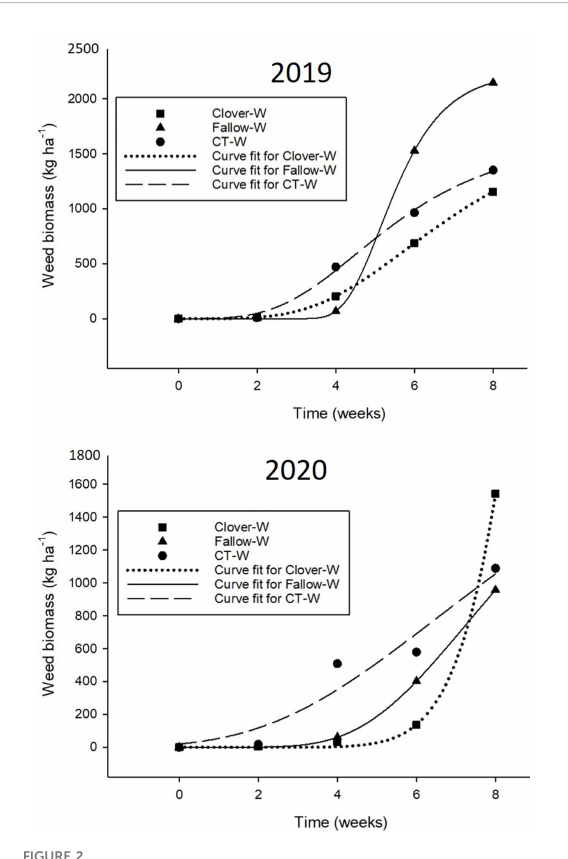
FIGURE 2 Weed biomass as a function of critical timing for weed removal CTWR (duration of weed interference with corn) for each of the conservation tillage following a crimson clover cover crop (CT + CC), conservation tillage following winter fallow (CT + WF), and conventional tillage without a cover crop (CVT) treatment in 2019 and 2020. Parameters of the models are presented in Table 4. W represented weedy; Fallow referred to winter fallow (CT + WF), clover referred to cover crop (CT + CC), and CT depicted conventional tillage